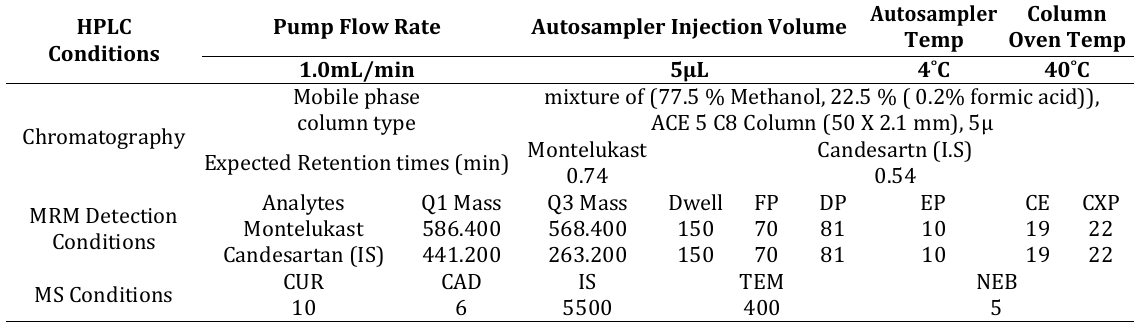
Table I. Chromatographic conditions and Mass Spectrometric conditions HPLC